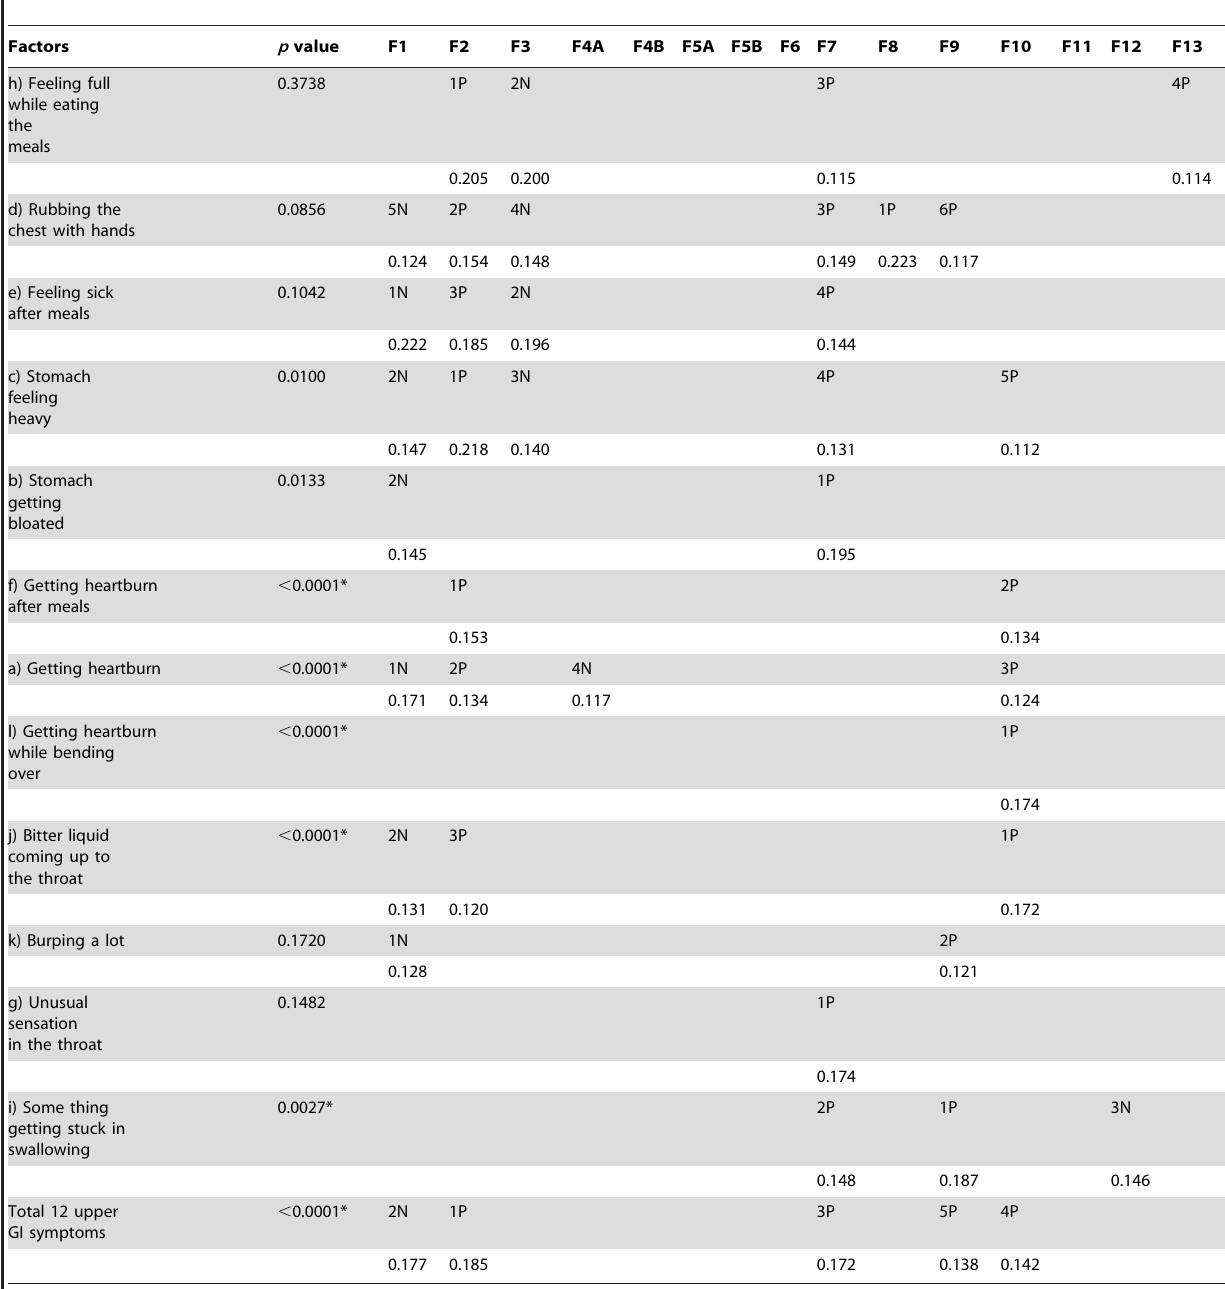
Table 3. Orders, directions, and standardized coefficients of associations between the 12 upper GI symptoms and 13 background factors among the 364 PPI